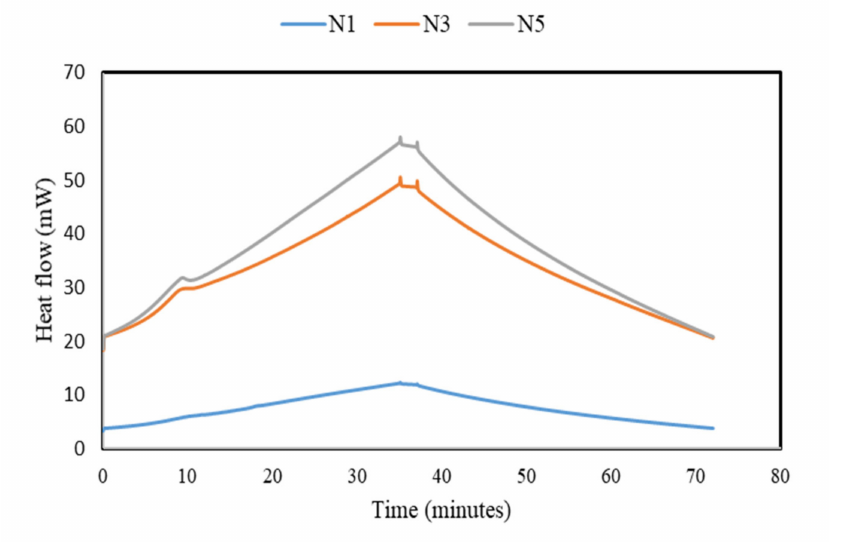
Figure 10. Heat evolution of